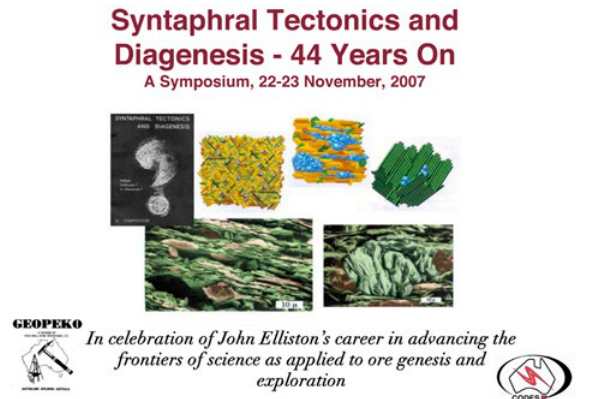
Figure 15. The introductory slide for the CODES Symposium at the University of Tasmania in November